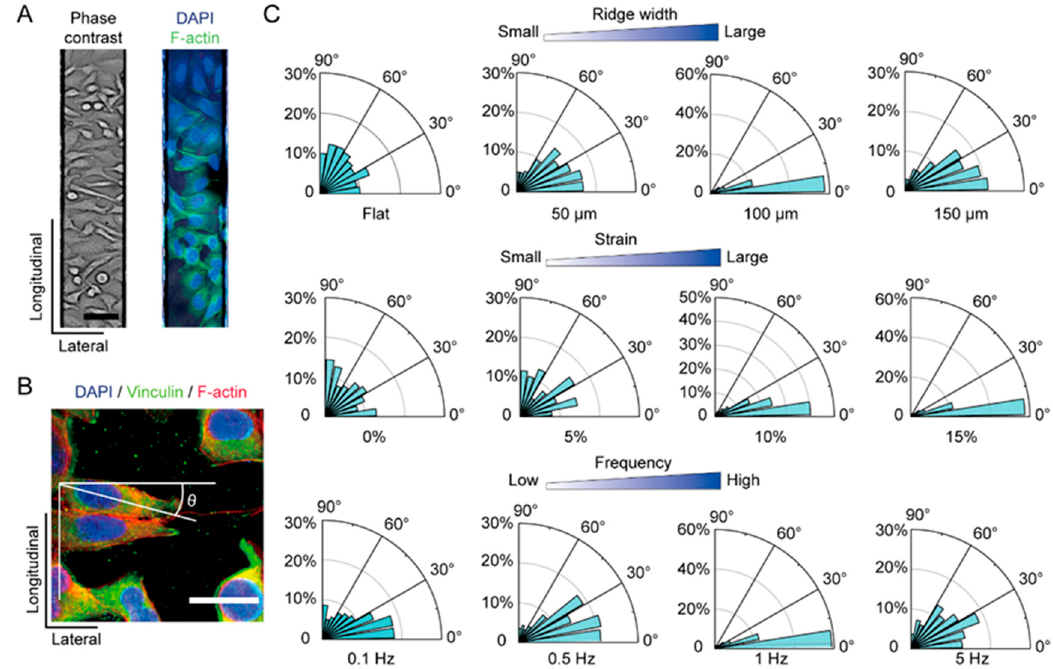
Figure 5. Cell orientation reflected the uniaxial strain feature of the stretching chip. ( A ) Representative phase contrast (left) and fluorescent (right) images of A549 cells cultured on a ridge surface of the stretching chip after being stretched at 1 bar for 24 h. Scale bar: 50 μ m. ( B ) Illustration of the cell orientation angle measurement. Scale bar: 50 μ m. ( C ) Angular distributions of the cell orientation of A549 cells under the indicated ridge width (top panel), strain (middle panel), and stretching frequency (down panel) conditions.